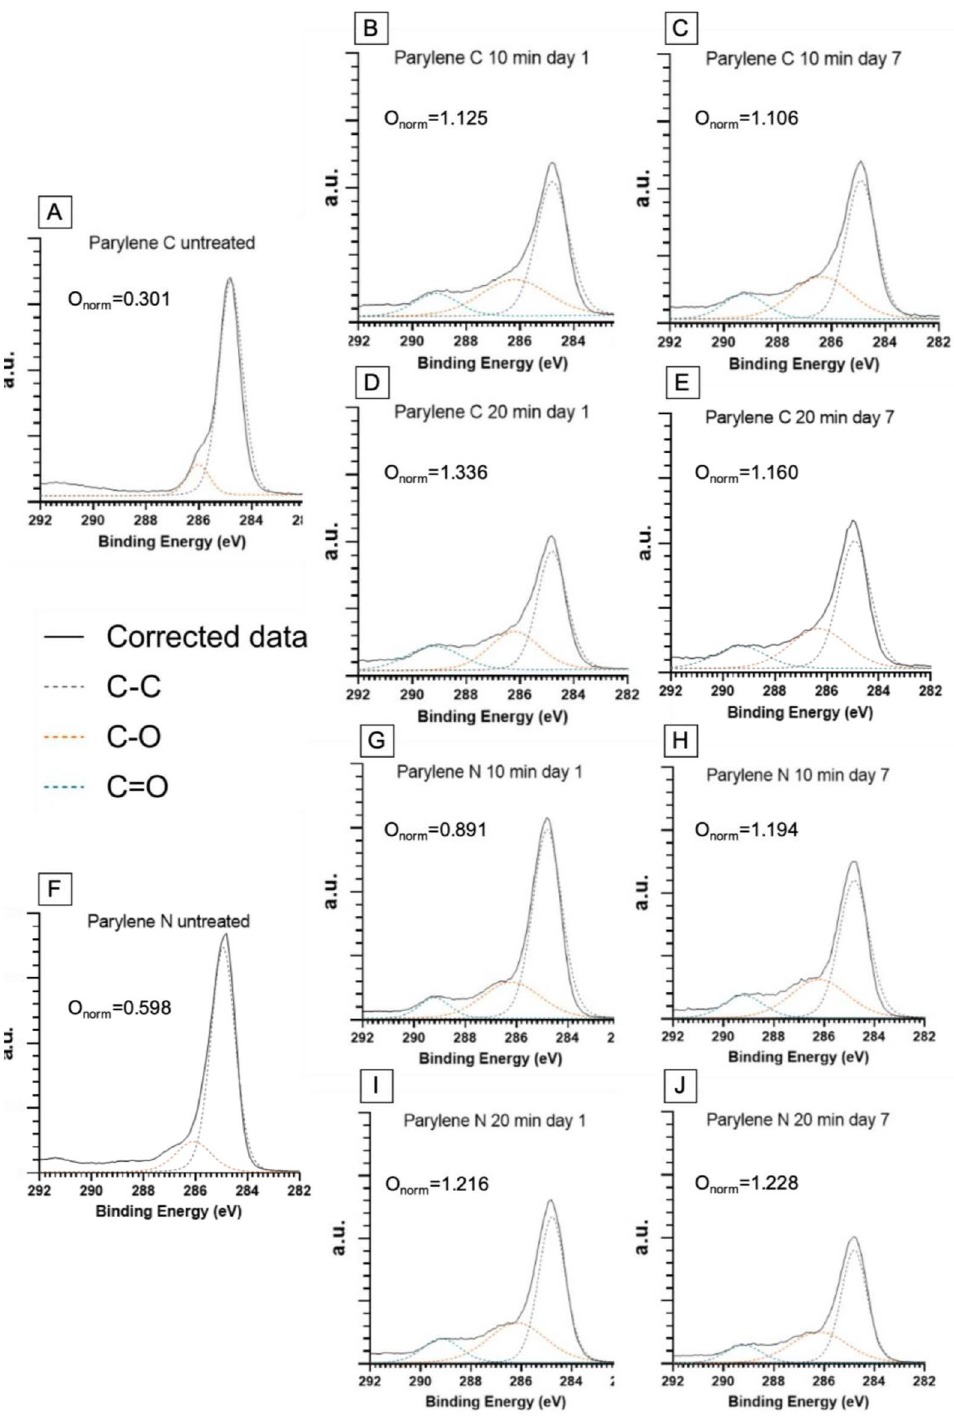
Figure 9. XPS visualization of high-energy tails associated with carbon bonding to oxygen for Parylene C ( A-E ) and Parylene N ( F-J ) membranes with different treatments on day 1 and day 7 and corresponding normalized oxygen concentrations extracted from the survey scans. Continuous black lines in each graph correspond to the corrected data, and the dotted lines are Gaussian–Lorentzian fits for carbon–oxygen (orange and blue) and carbon–carbon (gray)